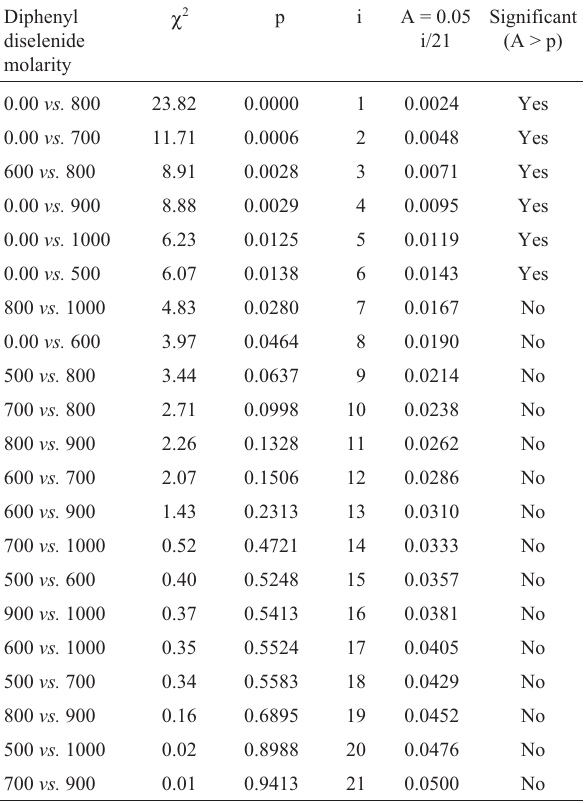
Table 3 - Pairwise chi-squared ( χ 2 ) comparisons of D. melanogaster adult lifespan for flies fed on banana-agar medium supplemented with different molarities ( μ mol/kg of medium) of diphenyl diselenide dissolved in dimethyl sulfoxide (DMSO). The comparisons use the Benjamini and Hochberg false discovery rate method and are ranked (i) in order of de- creasing χ 2 value and probability level (p) is in increasing magnitude. The corrected p-value (A) is equal to the p-value multiplied by the rank (i) and divided by the total number of comparisons (A = p i/21) for an error rate = 0.05. The treatments were significantly different in respect to devel- opmental rate when A > p, with the higher diphenyl diselenide molarities showing lower development rates. The control was DMSO only and 30 D. melanogaster eggs were used for the control and each diphenyl dise- lenide